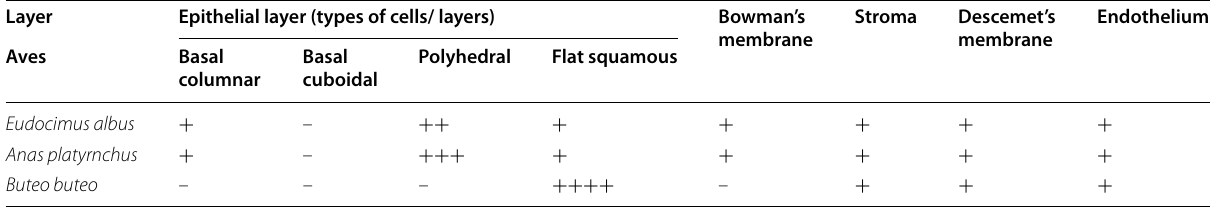
Table 2 Comparison between the thicknesses (Mean Species Total thickness (µm) Corneal layers